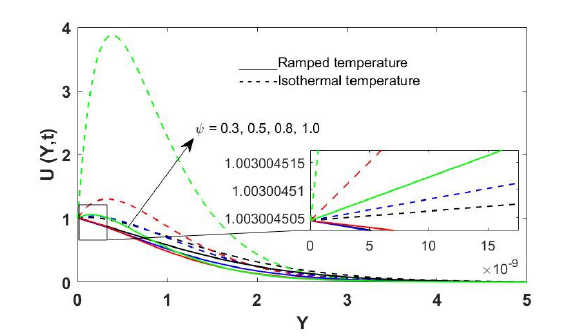
Figure 2: Momentum distribution versus ψ t =0.3, R=0.2, E=1, S=1, Q=0.2, K=1, kp=1.5, Ω = 30 0 , Pr =0.71, Sc =0.60, Gr=3, Gc=4